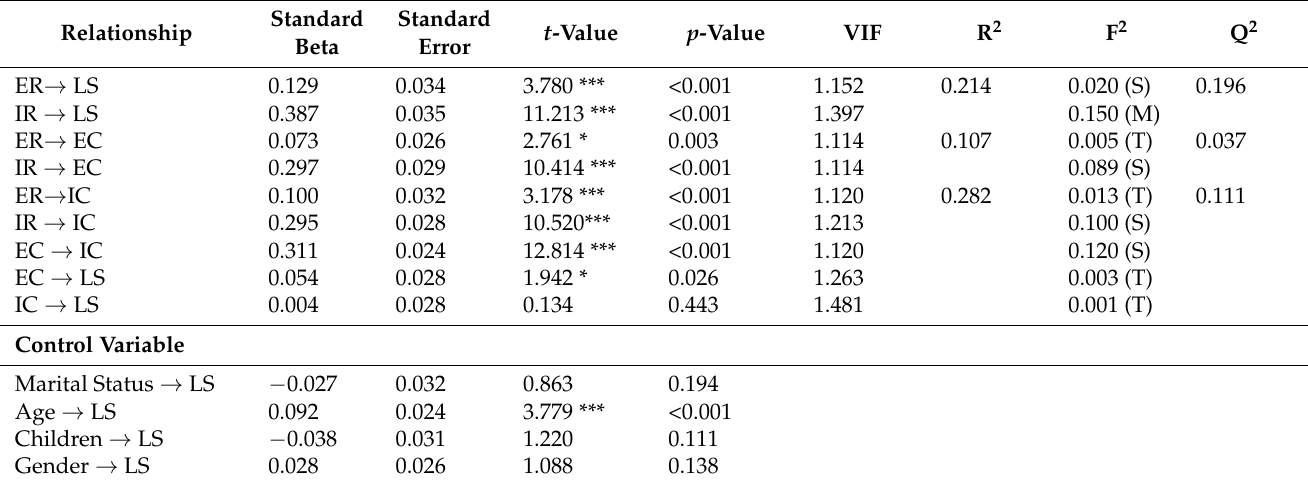
Table 4. The parameters of the structural equation model.